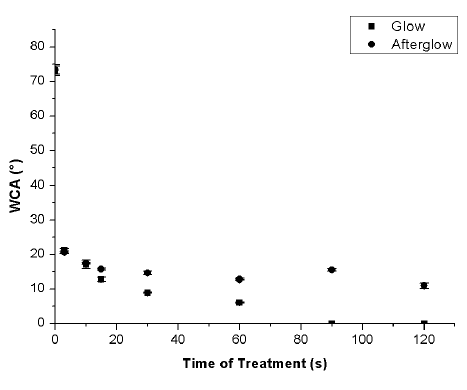
Figure 3 : The water contact angle versus treatment time for samples treated in plasma (lower curve) and afterglow (upper